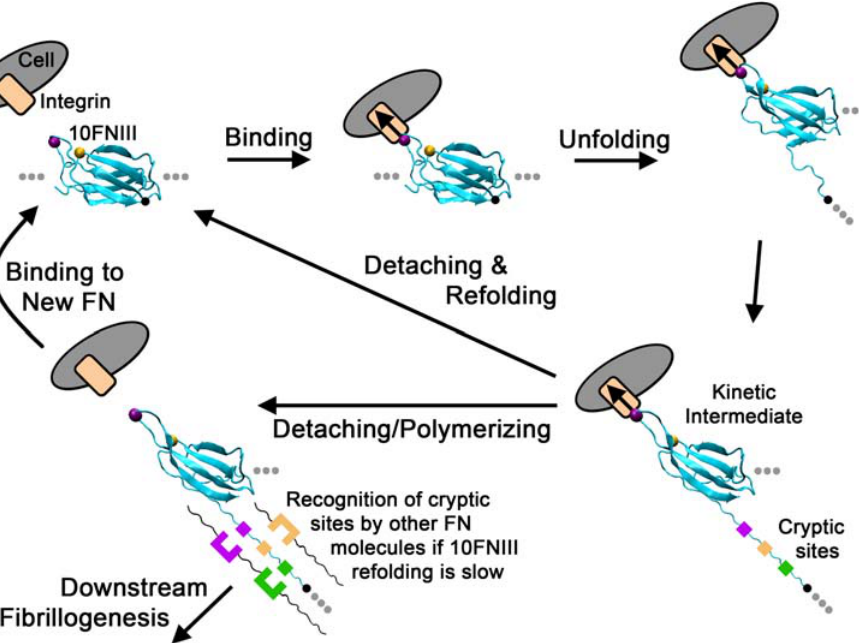
Figure 8. Cell-mediated Fibrillogenesis. The proposed model involves the formation of a partially unfolded intermediate during cell-traction mediated unfolding. Potential cryptic sites may exist in this partially unfolded structure that promote FN aggregation and fibrillogenesis. Subsequent unfolding past this intermediate induces a crucial arginine at a secondary binding site to move to a position far from the RGD loop. This frees the cell and enables it to reattach to another FN molecule to propagate the process. If 10FNIII refolding is relatively slow, then unfolded portions of this domain can make contacts with other FN molecules.